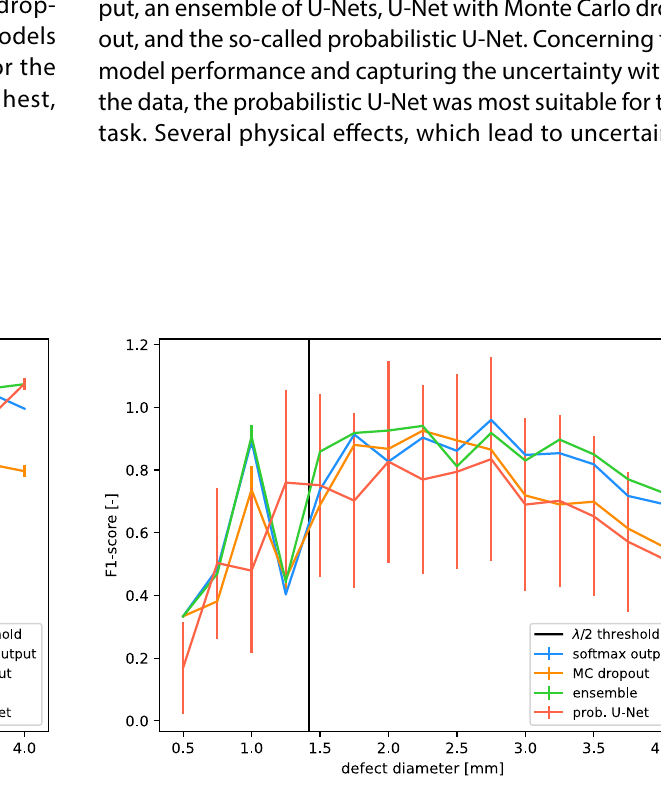
Fig. 15 Dependency of the F1-score from the defect size for round defect and micostructure